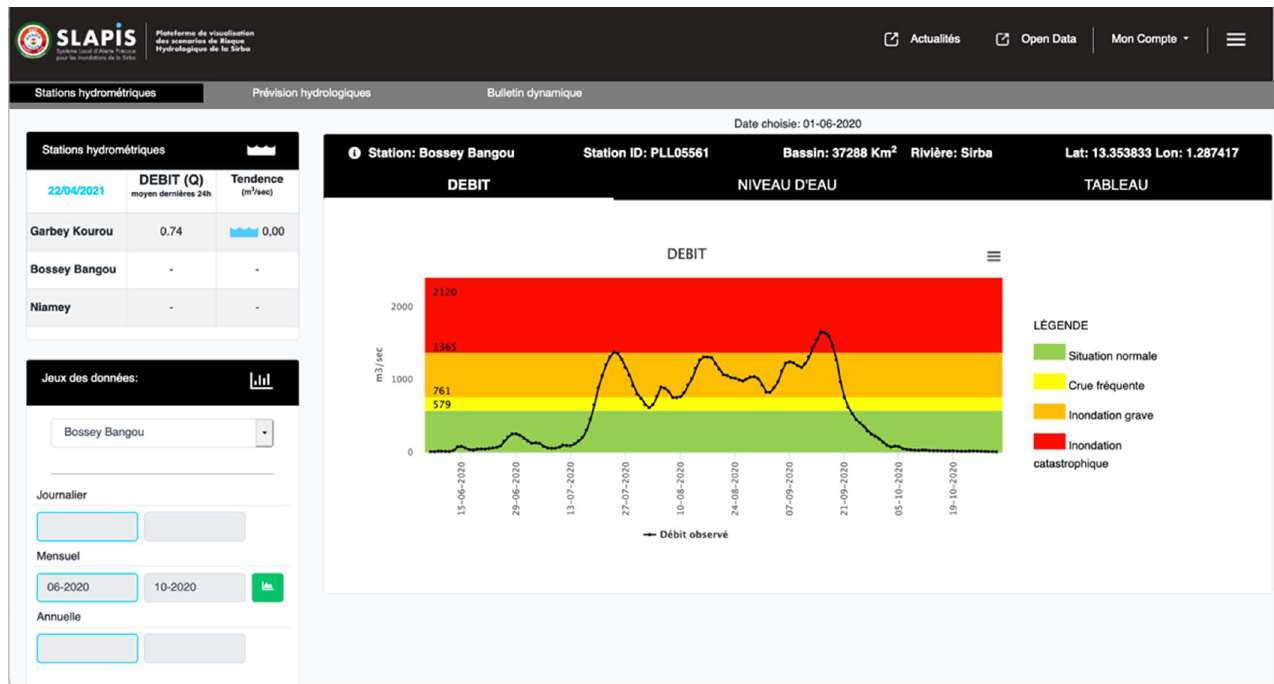
Figure 8. Web application interface: view of data catalogue and main menu.